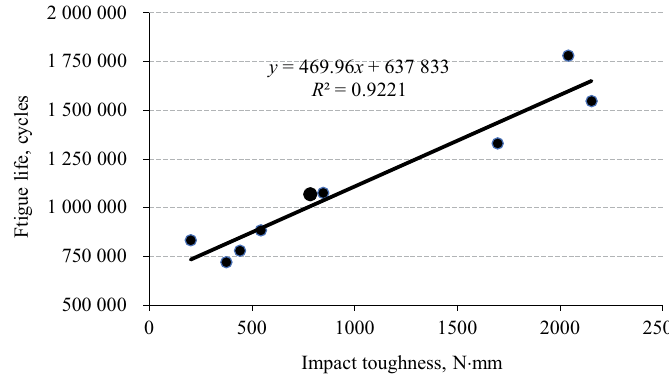
Figure 10. Relationship between impact toughness and fatigue life